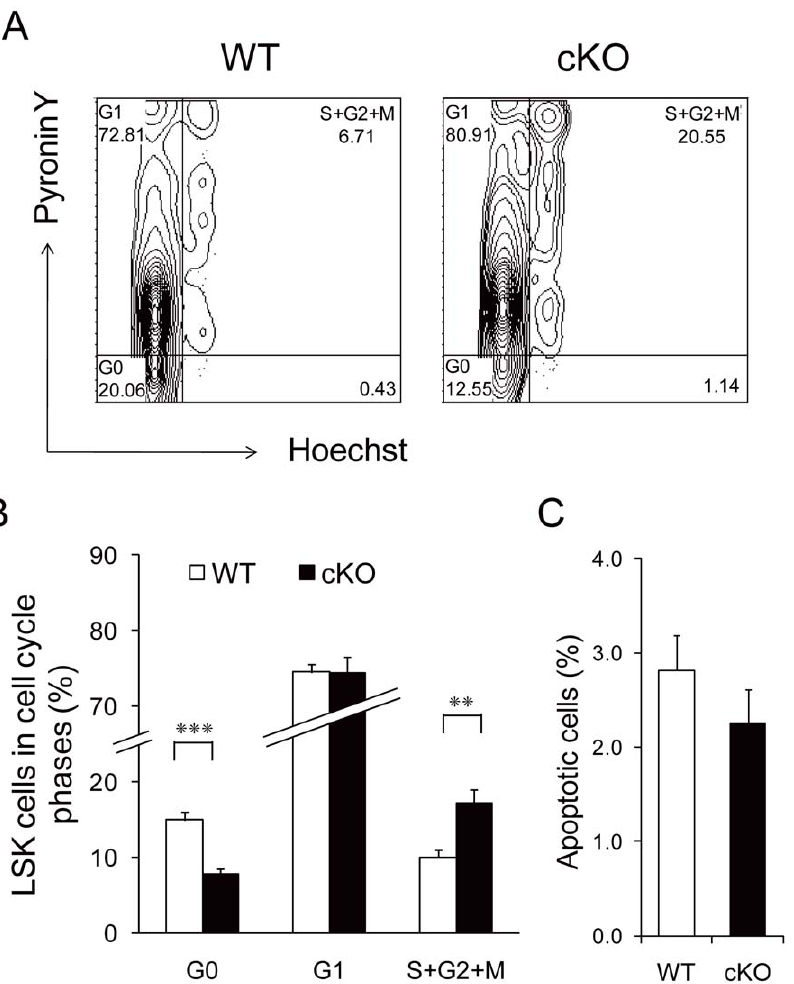
Figure 4. GRP94-deficient LSK cells displayed increased proliferation and loss of quiescence. A) Representative flow cytometric analysis of LSK cell cycle status by Hoechst and Pyronin Y staining. To examine early effects of GRP94 depletion on HSC proliferation, BM was extracted from WT and cKO mice 3 days after 4 shots of pI.pC injection every other day. B) Summary of cell cycle distribution of LSK cells from WT and cKO mice (n=7). C) Summary of flow cytometric analysis of apoptotic LSK cells using Annexin V and 7AAD (n=5 for WT, n=8 for cKO) (p=0.324). All data are presented as mean 6 s.e., **p , 0.01, ***p , 0.001.